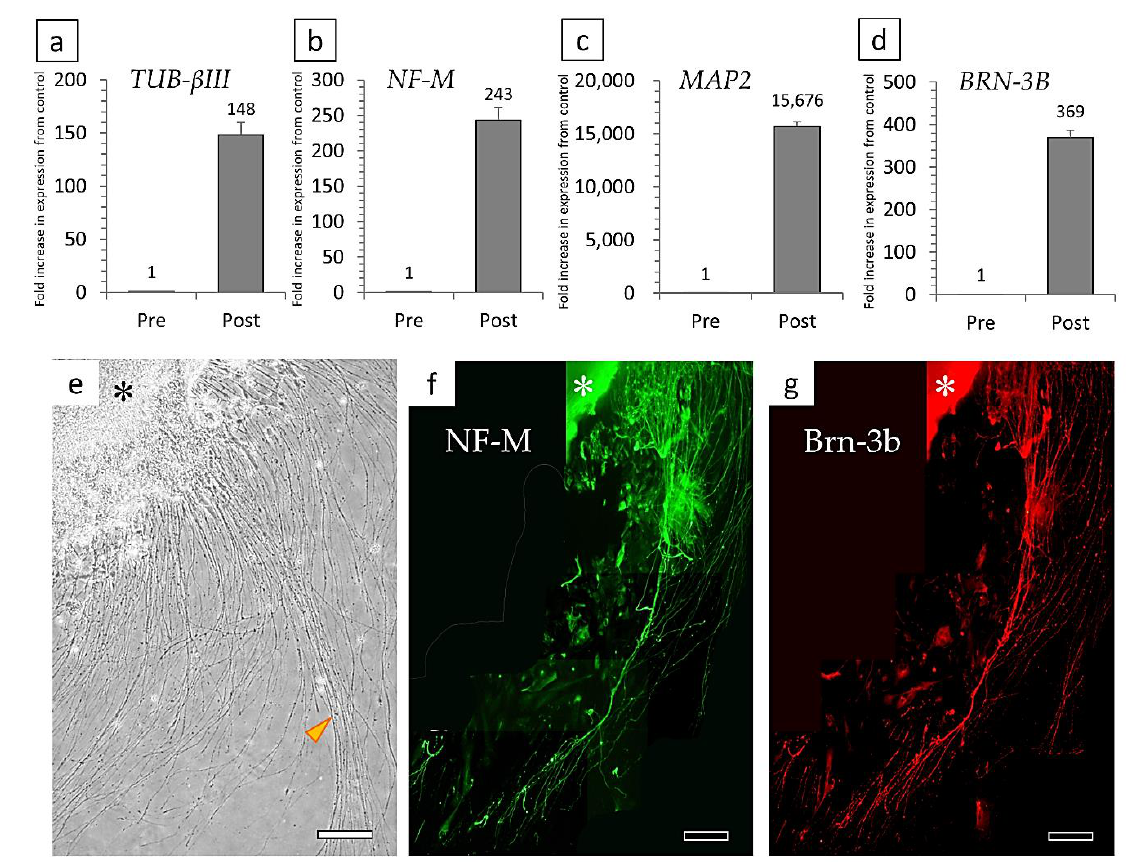
Figure 8. Relative semi-quantitative analysis of the gene expressions of ( a ) TUBULIN- β III , ( b ) NEUROFILAMENT-M , ( c ) MAP2 , and ( d ) BRN-3B in pre/post-differentiated cells. ( e ) An adhesive culture of cell aggregates (*) formed in suspension culture resulted in very long neurite outgrowth ( arrowhead ). ( f , g ) Fluorescent immunostaining results for markers of retinal ganglion cells: ( f ) Neurofilament-M, and ( g ) Brn-3b. Bars: 200 μm.